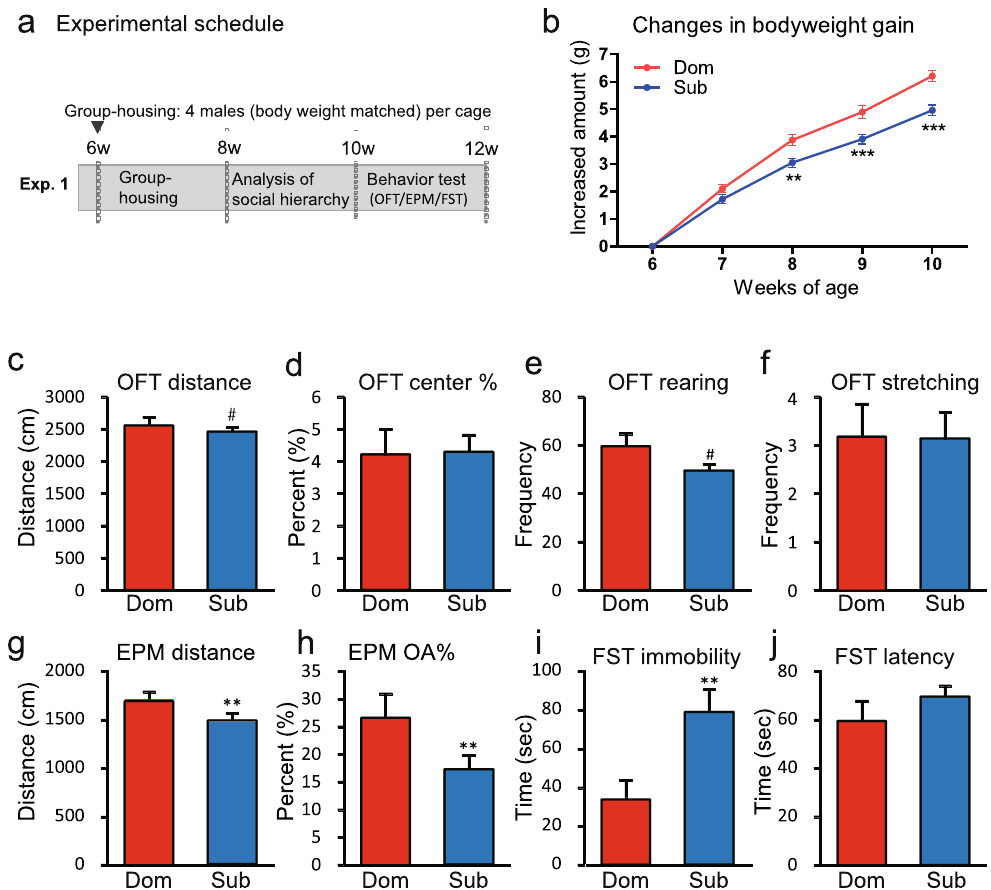
Figure 2. Effects of social hierarchy on growth and behaviour. ( a ) Experimental schedule. The social hierarchy was determined by analysing dyadic agonistic interactions between each combination of two males in the home cage for 2 weeks (when the mice were aged 8–10 weeks). In Experiment 1, all of the animals were used in behavioural tests at age 10–12 weeks ( n = 16 cages). ( b ) Comparison of body weight gains in different hierarchies in group-housed mice ( * P < 0.05, ** P < 0.01, dominant versus subordinate). The behaviours of the dominant (Dom) and subordinate (Sub) males were compared. ( c – f ) Open-field test (OFT) results for ( c ) the distance travelled, ( d ) the percentage of time spent in the central area, ( e ) the rearing frequency, and ( f ) the stretching frequency. ( g and h ) Results of the elevated plus-maze (EPM) test, showing ( g ) the distance travelled and ( h ) the percentage of time spent in the open arms. ( i and j ) Results of the forced swim test (FST), showing ( i ) the immobility time and ( j ) latency to immobility ( # P < 0.1, ** P <